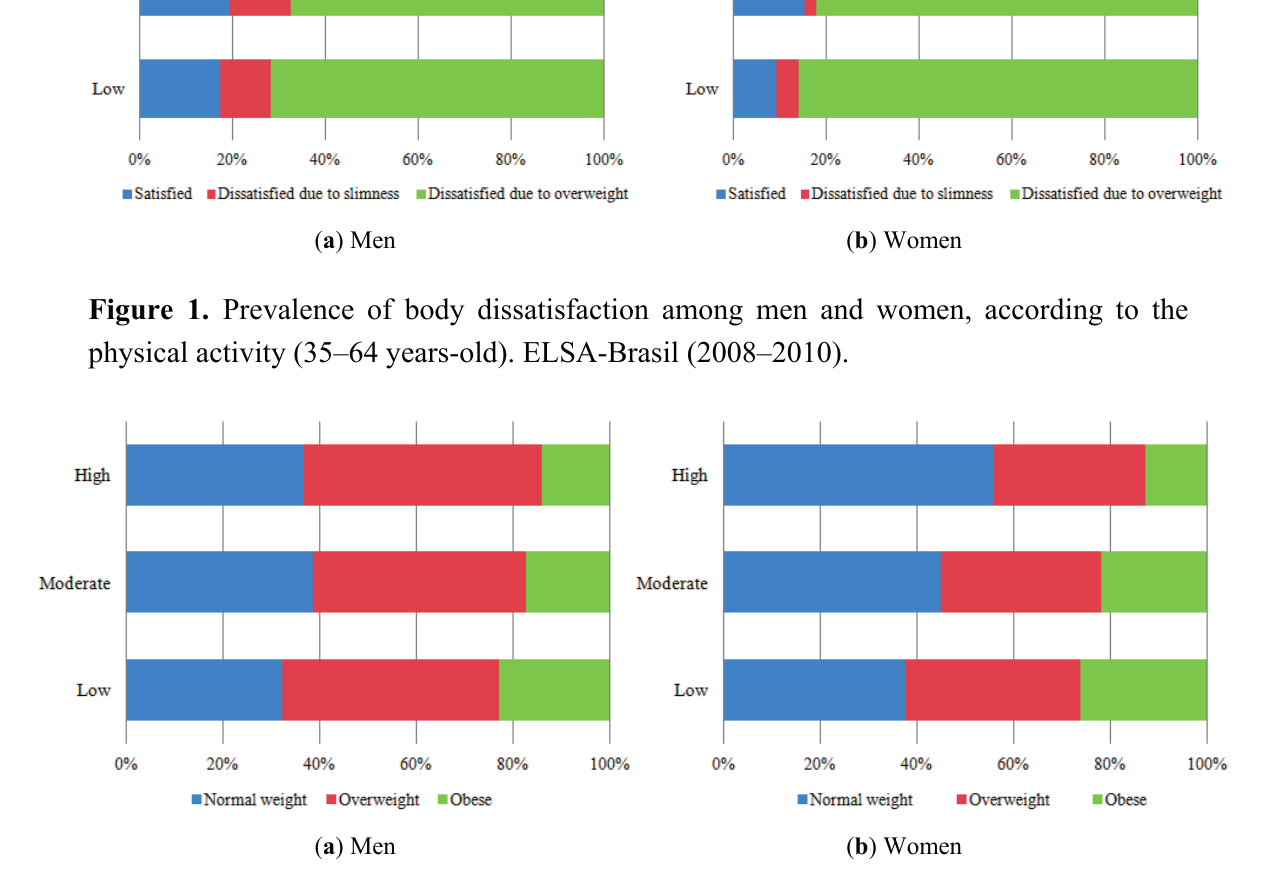
Figure 2. Prevalence of BMI among men and women, according to the physical activity (35–64 years-old). ELSA-Brasil